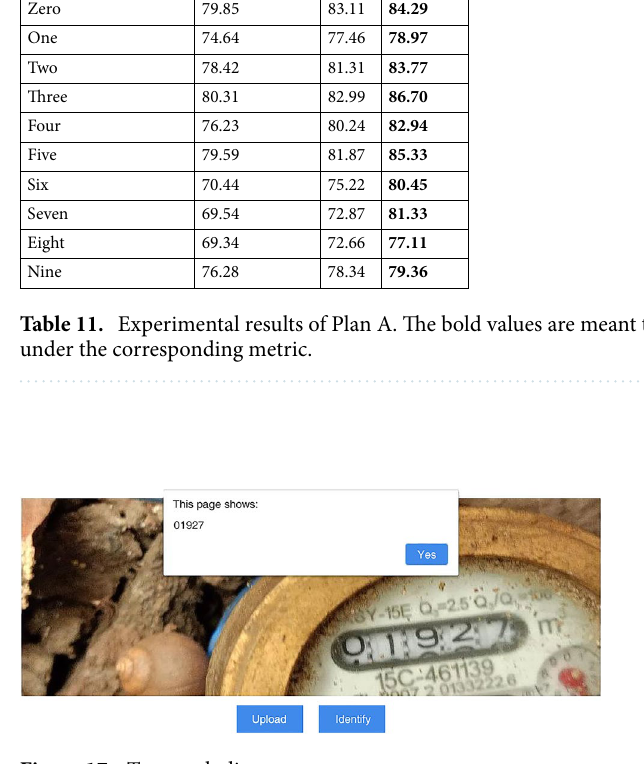
Figure 17. Test result